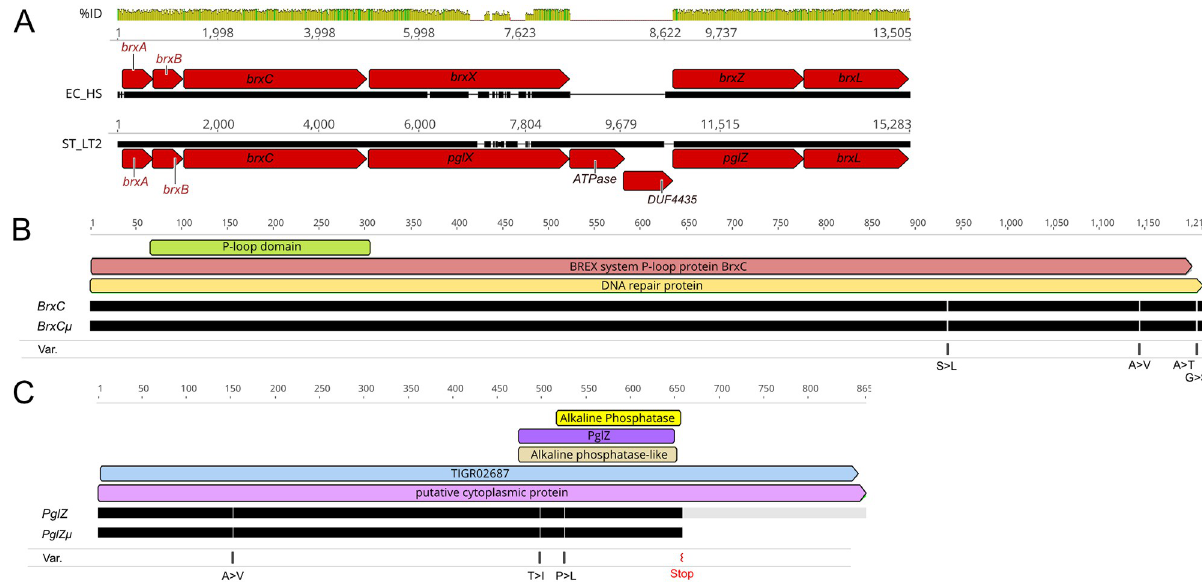
Fig 1. StySA locus similarity to E . coli BREX DNA sequence and protein variants in ER3625. Panel A: DNA alignment of BREX regions from LT2 and E . coli HS. %ID: dark green 100% identity, light green, close similarity, white: missing regions. Numbers: nt coordinates of segments extracted from the genome sequences (EC_HS, ST_LT2). Red arrows: annotated BREX genes; black segments: aligned nt, with breaks where the two don’t match. Panels B and C: Domain assignments and protein alignments for BrxC (LT2) and BrxC μ (ER3625), panel B; and PglZ (LT2) and PglZ μ (ER3625), panel C. Colored boxes: domain predictions; black lines: aligned aa sequences with breaks at variant positions and a grey extension for the LT2 PglZ C- terminal region after the stop codon in ER3625; Var: amino acids changes found in ER3625.